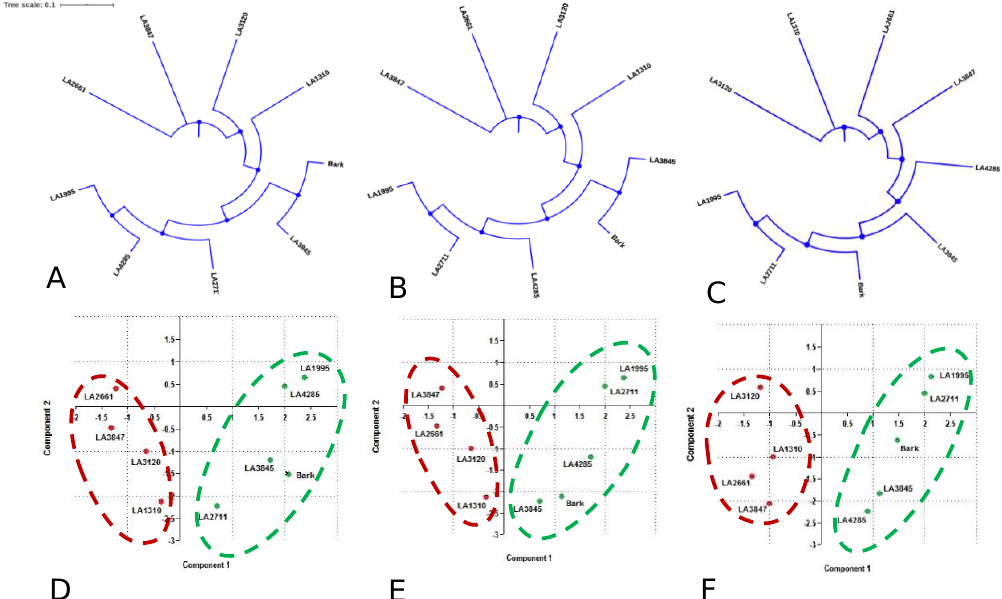
Figure 1. Cluster analysis based on Jaccard’s similarity coefficient of the combined analysis ( A ); CDDP and SCoT), CDDP analysis ( B ) and SCoT analysis ( C ) of the nine tomato genotypes. Principal Component Analysis (PCA) of the combined data analysis ( D ); CDDP and SCoT), CDDP analysis ( E ) and SCoT analysis ( F ) of the nine tomato genotypes showing the two-dimensional plot (PC1 and PC2).